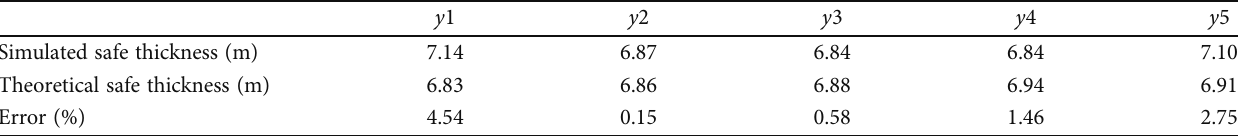
Table 11: Simulated and theoretical values of minimum safe thickness under the condition of fl exural strength. y 1